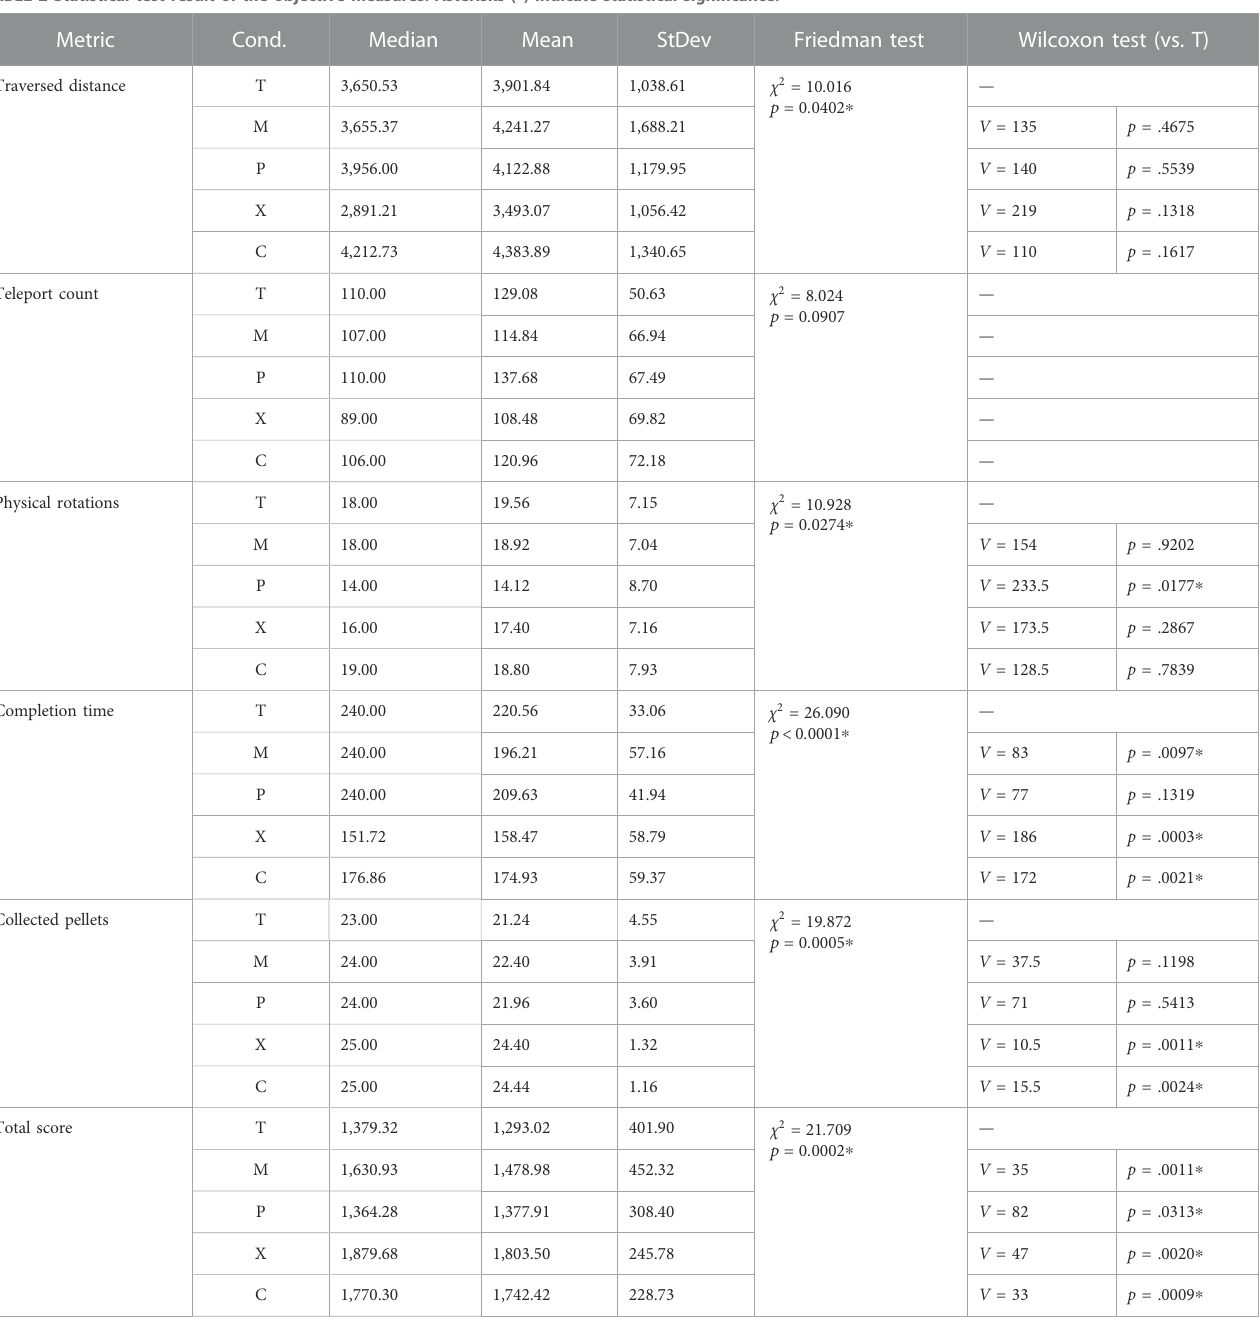
TABLE 2 Statistical test result of the objective measures. Asterisks (*) indicate statistical signi fi cance. Metric Cond. Traversed distance